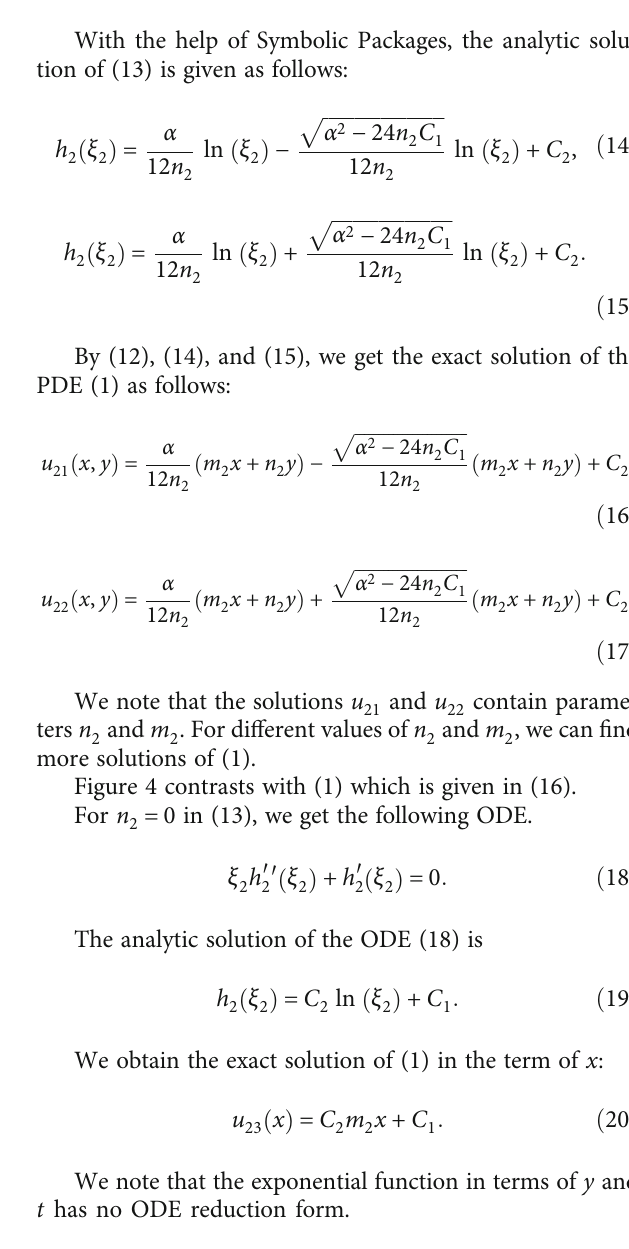
Figure 2: 3D plot of (10) for α = 1 :